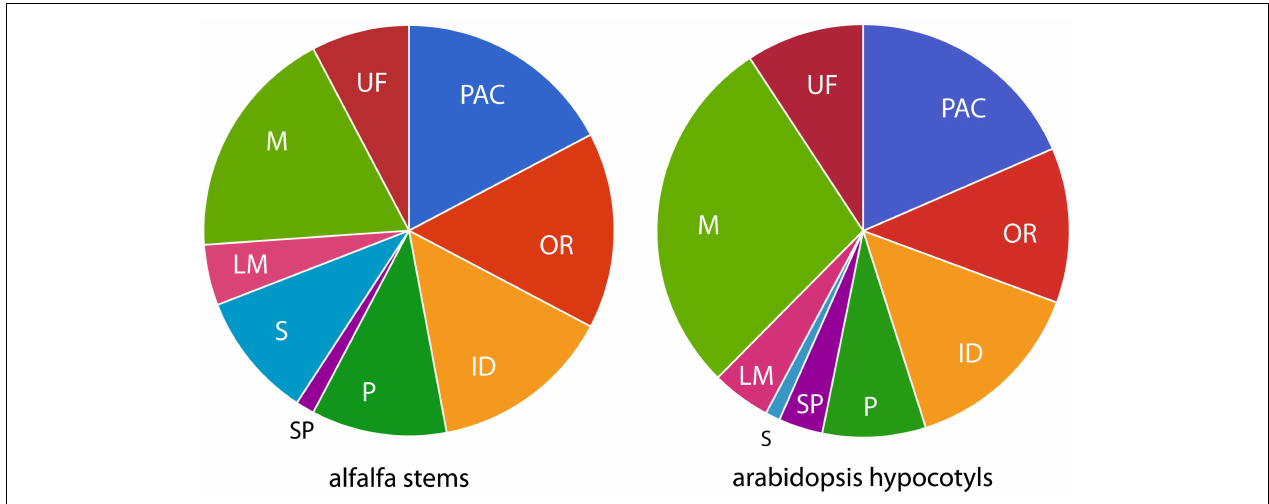
FIGURE 2 | Distribution of functional classes from proteomic studies. Functional classes are: PAC, proteins acting on carbohydrates; OR, oxidoreductases; ID, proteins with interacting domains; P, proteases; S, signaling; LM, proteins related to lipid metabolism; M, miscellaneous functions; UF, unknown